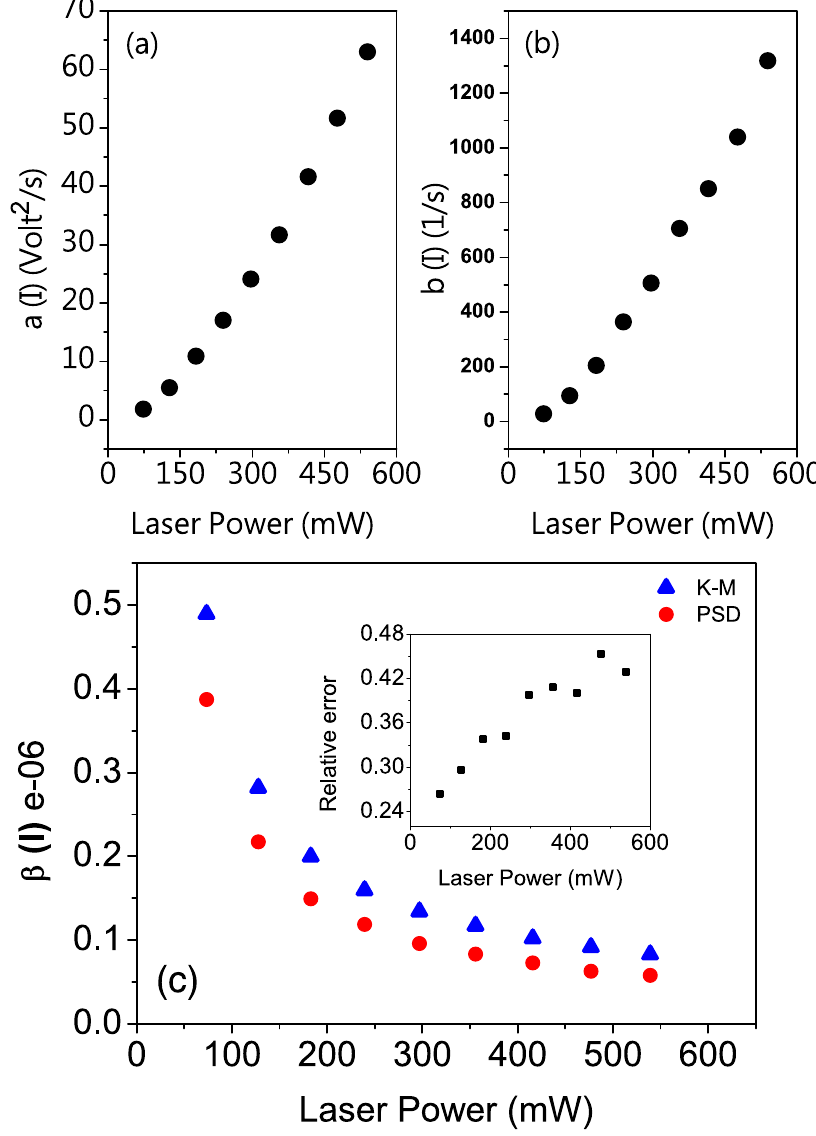
Figure 9. Intensity-dependence of the Diffusion coefficient. Intensity-dependence of the coefficients ( a ) a ( I ), ( b ) b ( I ), and ( c ) the conversion factor β , resulted from the KM and PS methods. The inset shows the relative error for the PS method as a function of laser power. The coefficient b ( I ) scales with intensity as I 1.5 for large